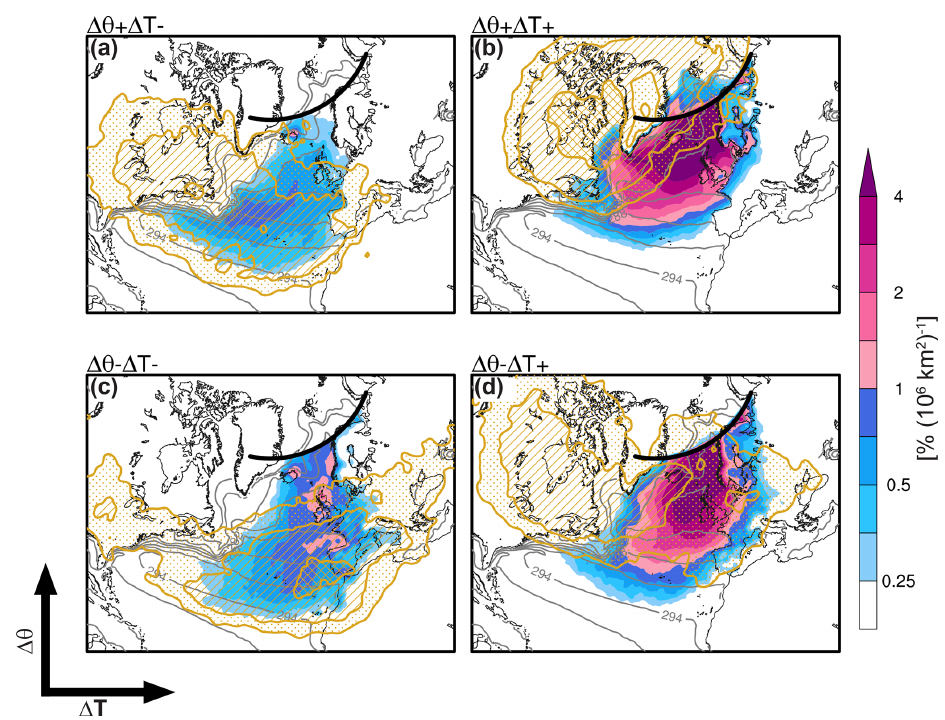
Figure 7. Moisture uptake per area as in Fig. 3 but for moist-air intrusions in the North Atlantic stratified by trajectory categories, i.e., for (a) (cid:49)θ + (cid:49)T − , (b) (cid:49)θ + (cid:49)T + , (c) (cid:49)θ − (cid:49)T − , and (d) (cid:49)θ − (cid:49)T + . The percentages are relative to the total of all four categories. The 1%, 2%, and 5% ( 10 6 km 2 ) − 1 probability contours of finding a trajectory of the given category at a certain location 6d prior to arrival at 70 ◦ N ( t = − 144h) are shown by yellow dotted, hatched, and cross-hatched areas, respectively. Gray contours show SST in intervals of 3K.